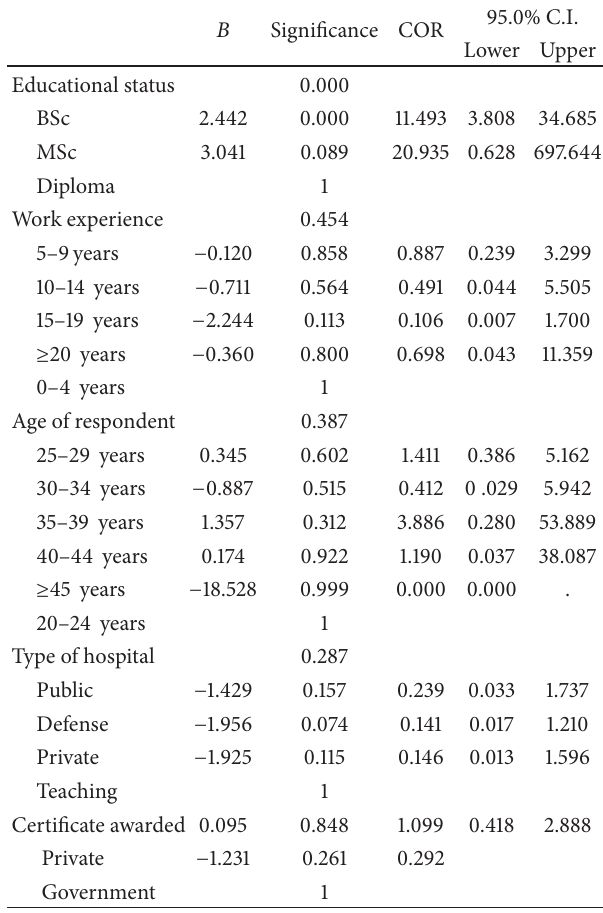
Table 4: Association of knowledge with sociodemographic char- acteristics on binary logistic regression in Mekelle Zone Hospitals, northern Ethiopia, March 2011. 𝐵 Significance COR 95.0% C.I. Lower